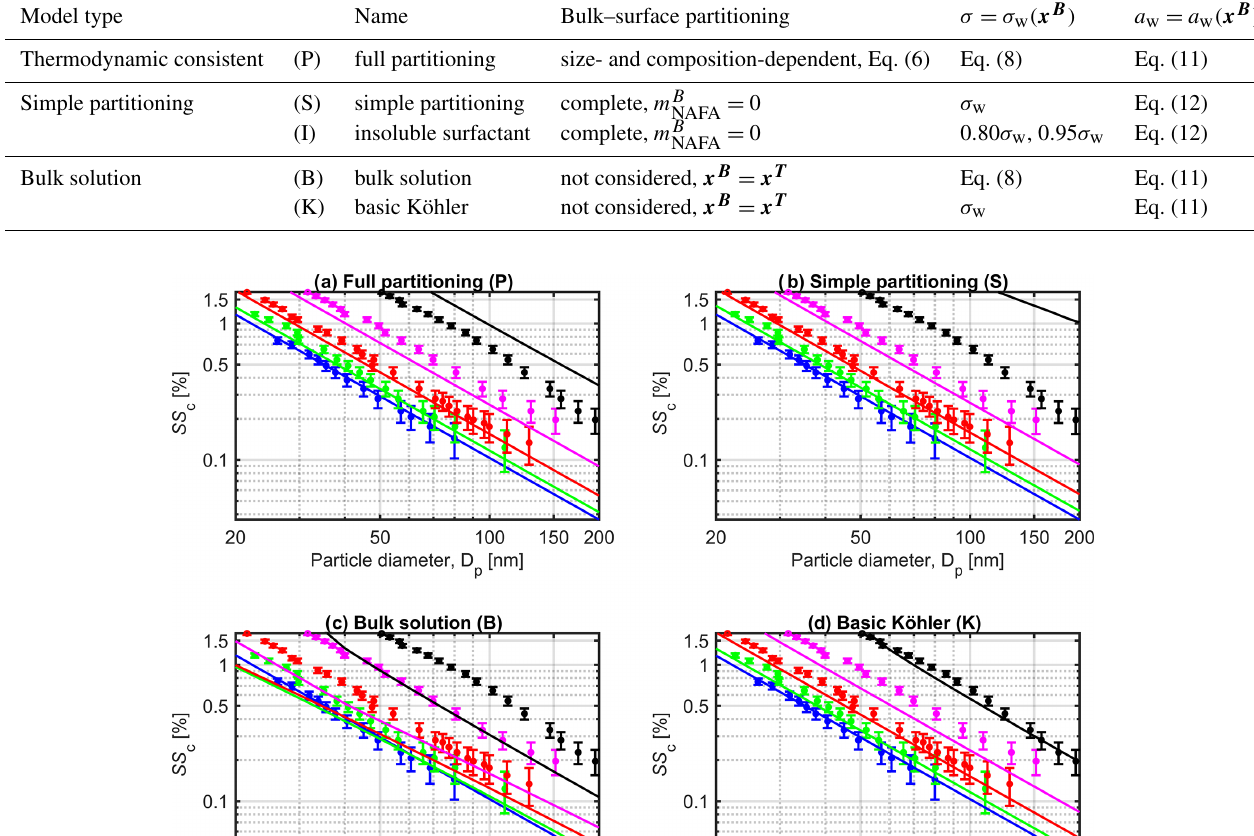
Table 1. Properties included in the different models used for Köhler calculations in this work.